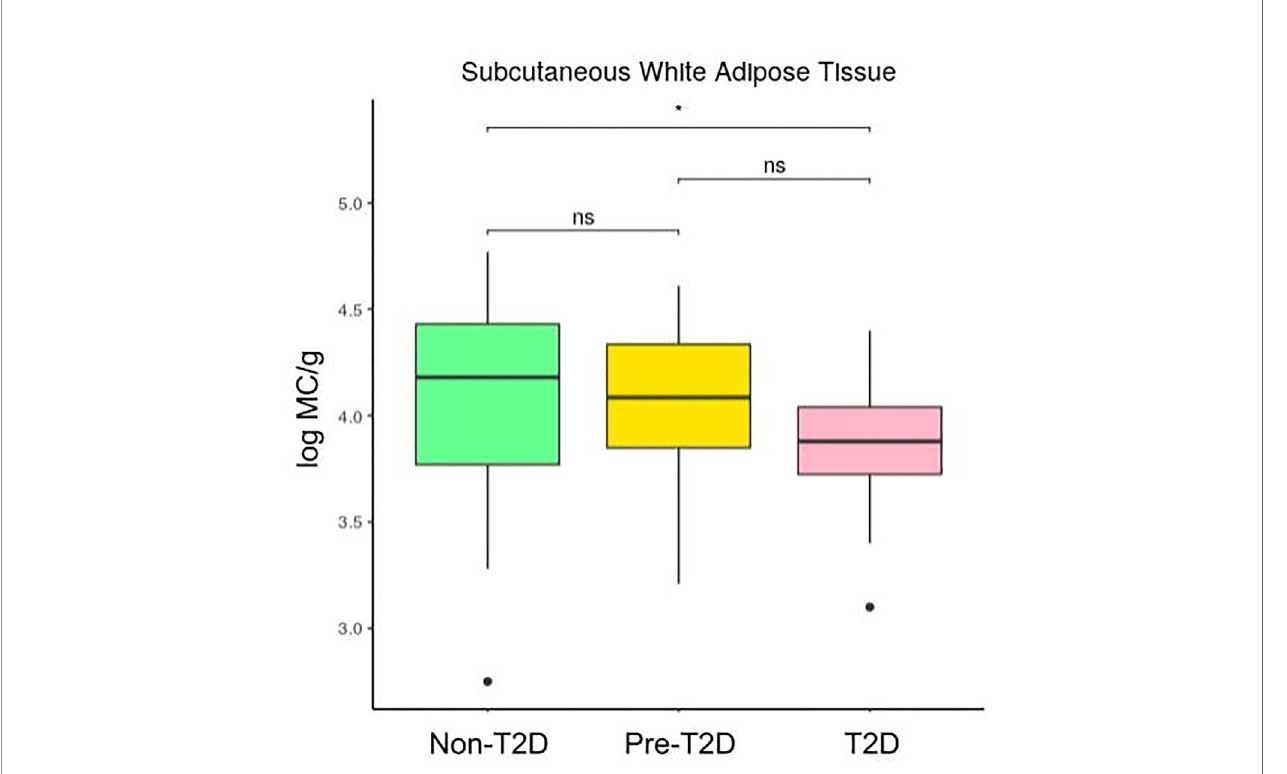
FIGURE 3 | Differences in mast cells per gram of tissue in subcutaneous white adipose tissue depending on the type 2 diabetes status. The data comes from the big cohort (n = 100). MC (mast cells), T2D (type 2 diabetes), “ ns ” (p-value > 0.05), “ * ” (0.05 > p-value >